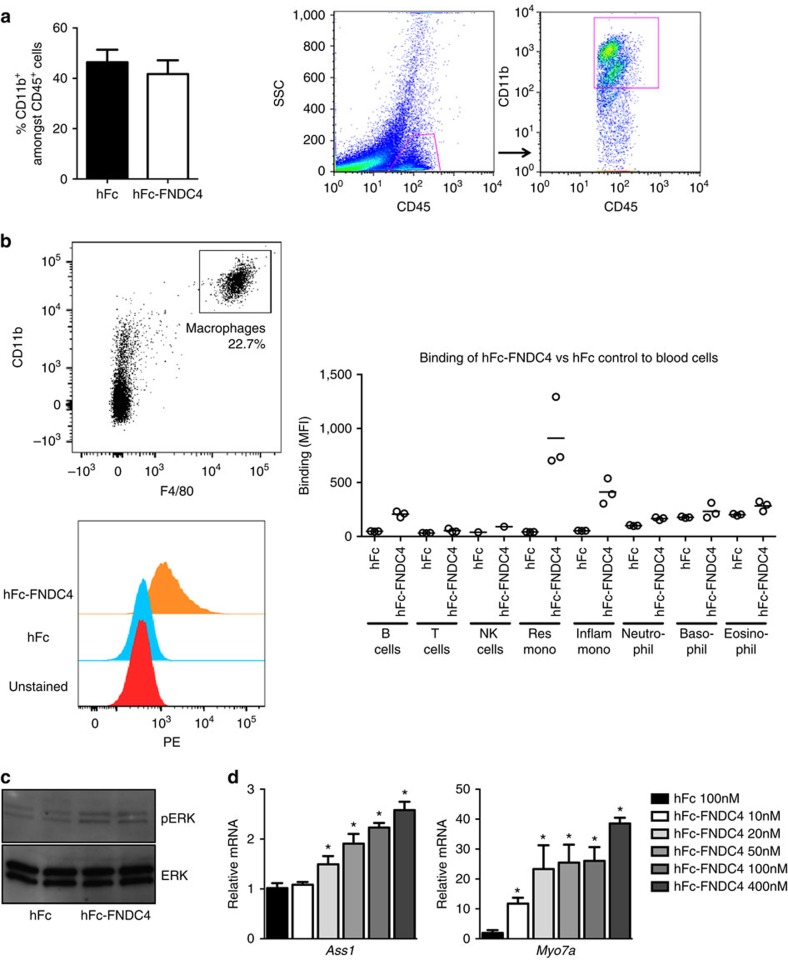
FNDC4 acts on macrophages.(a) Immune cell infiltration of DSS-mediated inflamed colon mostly consists of macrophages. Flow cytometry analysis of CD11b+-cells amongst CD45+ cells in the DSS colitis model. N=10 for the hFc control group, N=9 for the hFc-FNDC4 group. (b) FNDC4 binds to IgG Fc-gamma (IgG Fc-receptor negative) macrophages. The plots on the left show binding to peritoneal macrophages, the graph on the right shows binding to a panel of blood cells. Antibodies against CD11b and F4/80 were used to gate for macrophages. Binding of hFc-FNDC4 to cells was detected using a PE-conjugated antibody against human IgG. (c) ERK phosphorylation after 30 minutes of hFc-FNDC4 treatment. Total ERK served as loading control. This experiment was repeated twice with similar results. The full-size blot image is presented in Supplementary Fig. 11b. (d) Dose curve of hFc-FNDC4-mediated induction of Ass1 and Myo7a in bone marrow macrophages treated for 24 h with different concentrations of hFc-FNDC4 (100 nM hFc as control). Data are presented as mean±s.e.m., N=4. *P<0.05, One-way analysis of variance followed by Dunnett's post hoc tests.